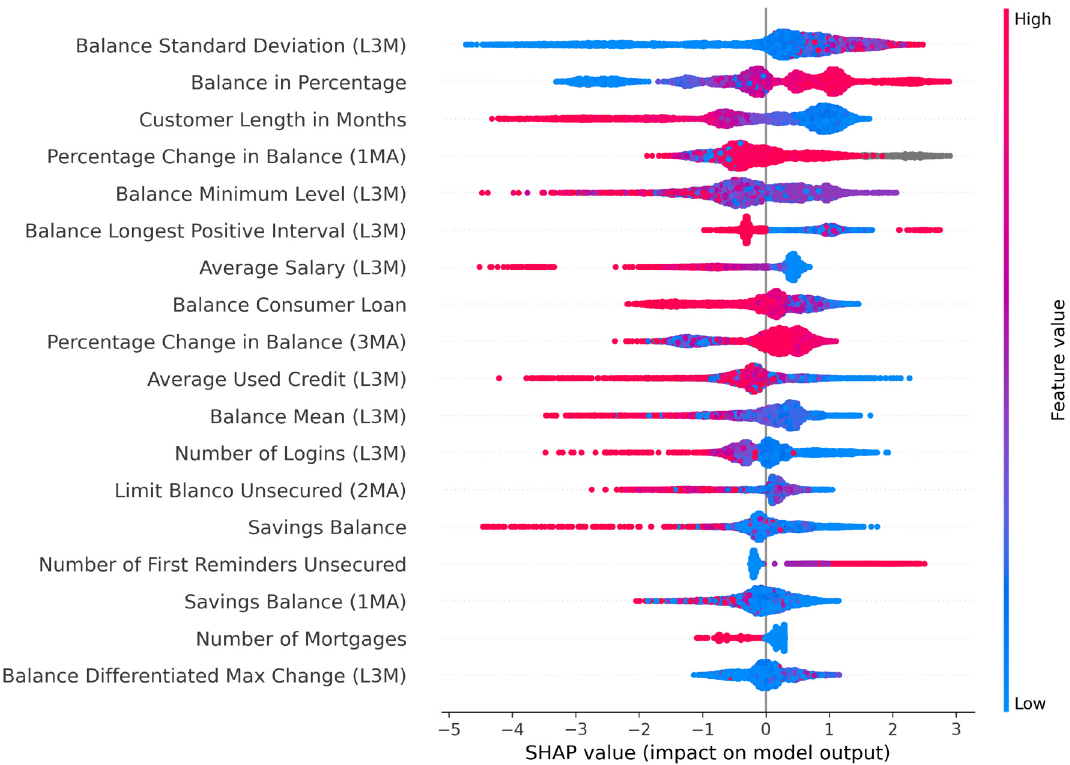
Figure 7. SHAP variable importance plot for the LightGBM model. Positive SHAP values are associated with an increase in default probability. Feature values are color-coded according to the scale on the right side, e.g., a high level of Customer Length in Months , shown in red, is associated with a decrease in default probability, whereas a low feature level, shown in blue, is associated with an increase in the probability of default. Missing values are colored grey, and all SHAP values are measured in